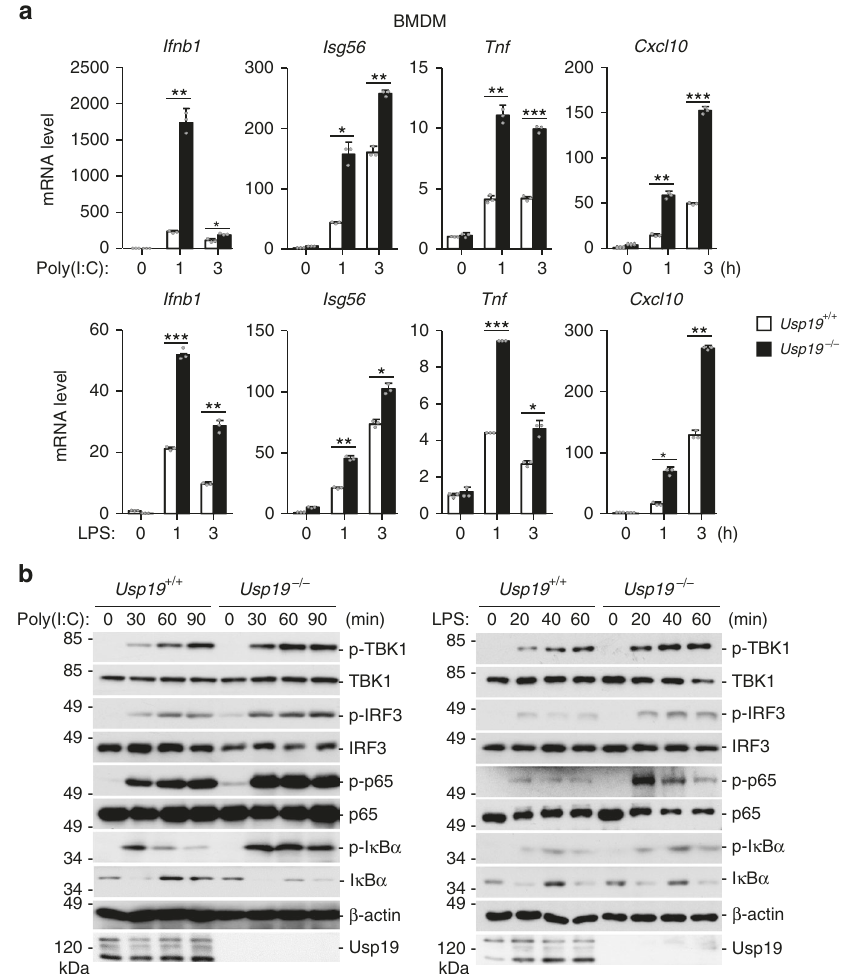
Fig. 2 USP19 negatively regulates TLR3/4-mediated signaling in primary cells. a Effects of USP19-de fi ciency on poly(I:C)- and LPS-induced transcription of downstream genes. Usp19 + / + and Usp19 − / − BMDMs were stimulated with poly(I:C) (50 μ g/ml), LPS (50 ng/ml) for the indicated times before qPCR with the indicated gene primers was performed. Graphs show mean ± SD; n = 3 independent samples. * P < 0.05, ** P < 0.01, *** P < 0.001 (unpaired t- test). b Effects of USP19-de fi ciency on poly(I:C)- and LPS-induced phosphorylation of TBK1, p65, IRF3, and ΙκΒα . Usp19 + / + and Usp19 − / − BMDMs were stimulated with poly(I:C) (100 μ g/ml) or LPS (100 ng/ml) for the indicated times before immunoblots were performed with the indicated antibodies. Data are representative of three experiments with similar results. Source data are provided as a Source Data fi le. Error bars represent standard deviation of the